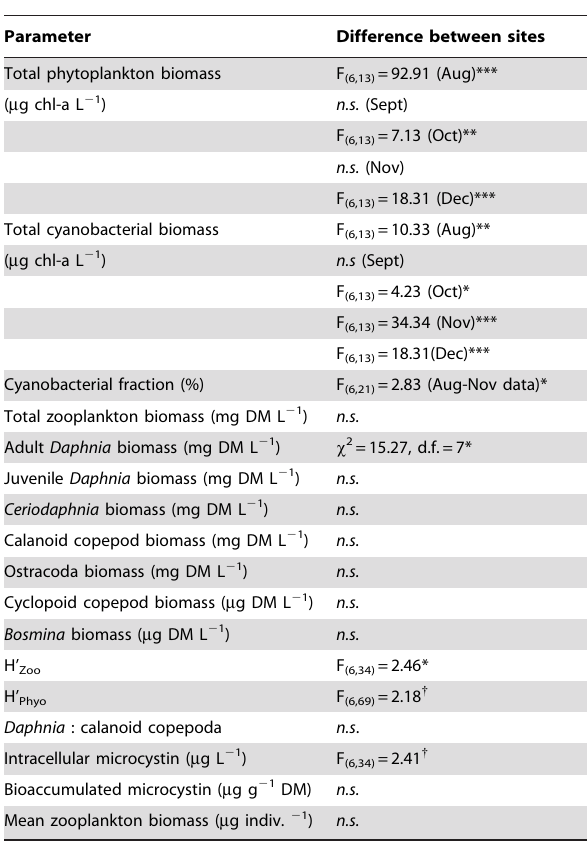
Table 3. One-way ANOVA and Kruskal-Wallis test results.